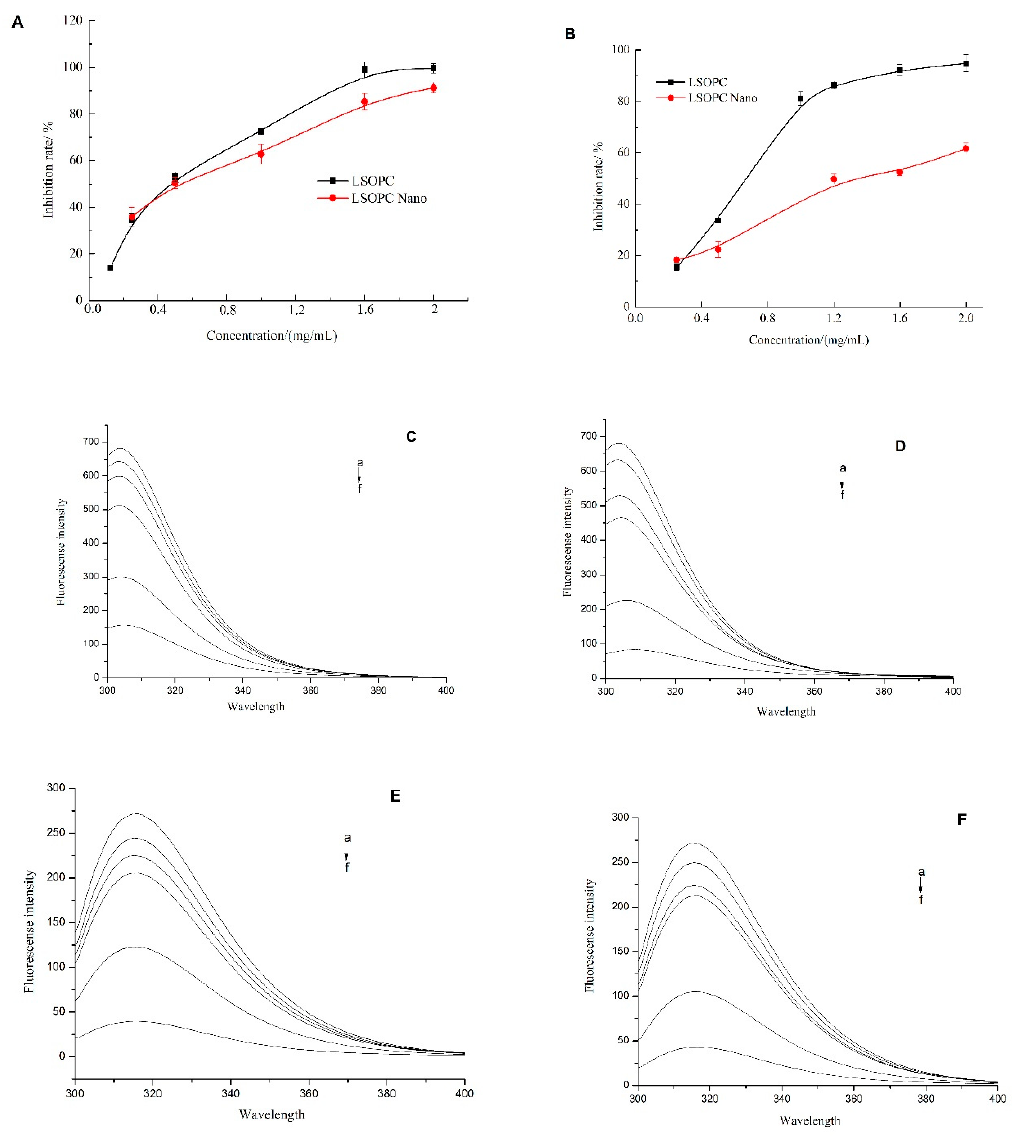
Figure 2. Inhibition effects of LSOPC and LSOPC Nano on monophenolase ( A ) and diphenolase ( B ), respectively. Fluorescence spectra of L -tyrosine in the presence of different concentrations of LSOPC ( C ) and LSOPC Nano ( D ). Fluorescence spectra of L -3,4-dihydroxyphenylalanine ( L -DOPA) in the presence of different concentrations of LSOPC ( E ) and LSOPC Nano ( F ). (a)–(f): 0, 25, 50, 100, 250, and 500 μ g/mL.